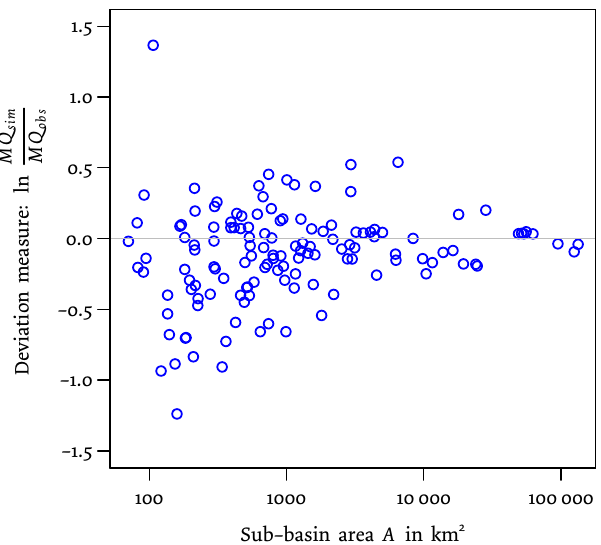
Fig. 1. Dependency of model discharge deviation on sub-basin size. For compatibility of positive and negative deviations, the logarithm of the relation of simulated to measured mean discharge has been used as error